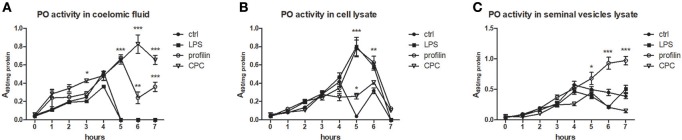
Activation of proPO system in earthworm celomic fluid, cells and seminal vesicles. ProPO activation of (A) coelomic fluid, (B) coelomocyte lysate supernatant, and (C) seminal vesicles lysate supernatant was assessed after the preincubation in vitro with LPS, profilin and CPC during 7 h. The significance was evaluated by two-way ANOVA with Bonferroni posttest in the GraphPad Prism software (*P < 0.05; **P < 0.01; ***P < 0.001).